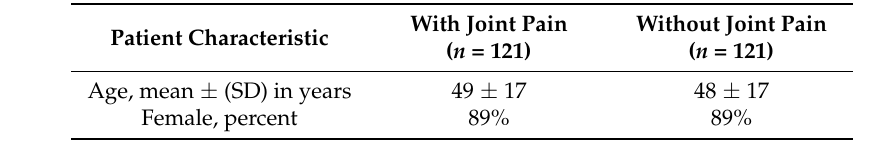
Table 1. Patient characteristics 20 months post chikungunya infection.